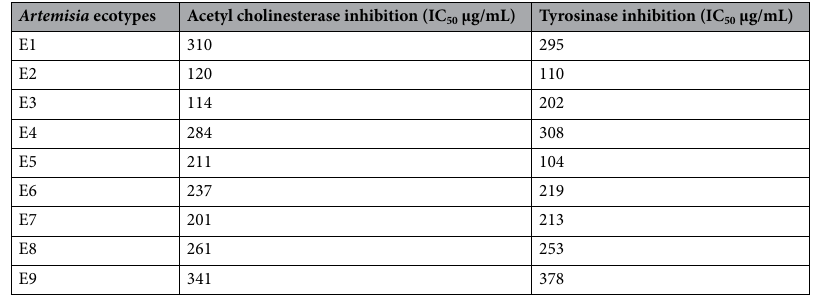
Table 2. Inhibitory activity of Artemisia ecotypes extract. E1: A.tournefortiana (Kerman province), E2: A.tournefortiana (North Khorasan province), E3: A.tournefortiana (West Azerbaijan province),